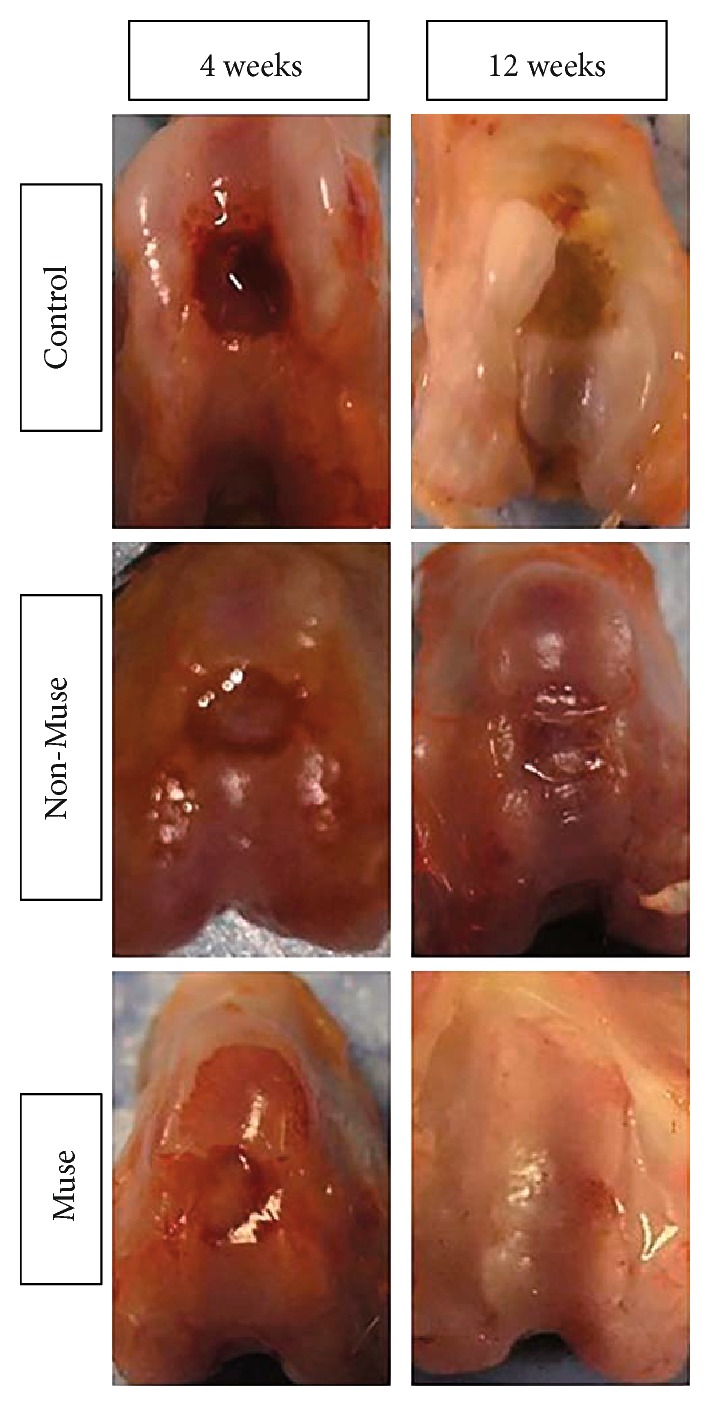
Macroscopic findings of the repaired tissue in the control, non-Muse, or Muse groups at 4 and 12 weeks, with complete filling of the defect with white tissue at the same level as normal tissue in the Muse groups at 12 weeks.